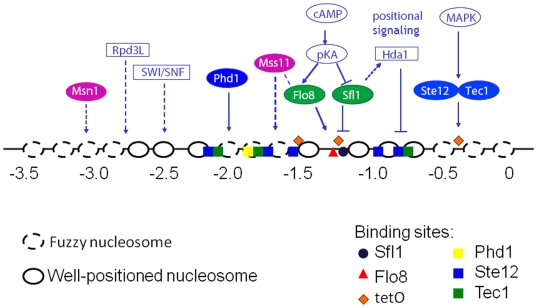
Signals from many trans factors converge at the complex FLO11 promoter.Regulators of FLO11 transcription. Nucleosomal positions are based on a thermodynamic model for nucleosomal occupancy [37]. Binding sites are approximate and based on literature but most sites have not been confirmed directly. The three locations where a tetO sequence was inserted are also shown. See main text, Text S1, and Figure S1 for further details.